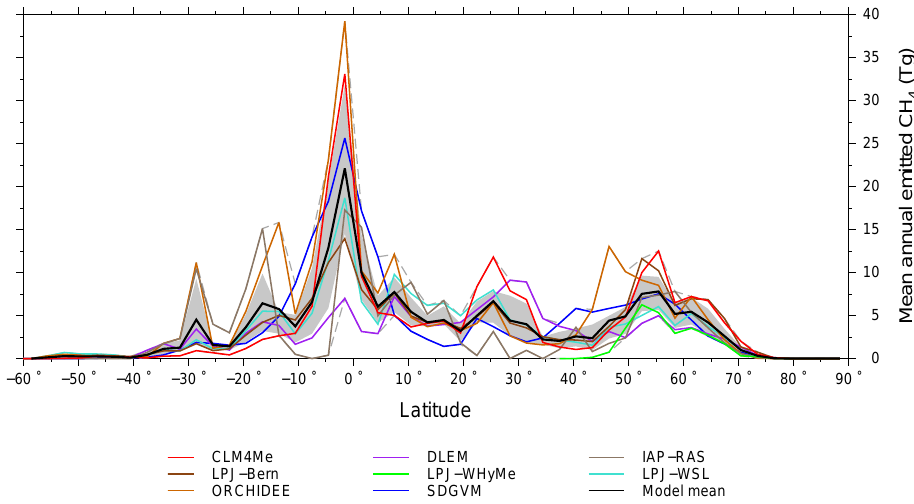
Fig. 5. Zonally summed mean annual CH 4 emissions for 1993–2004. The grey shading denotes the limits of the 25th and 75th percentile of the model distribution. Grey dashed lines are the 5th and 95th percentile limits. The CH 4 emissions are summed across 3 ◦ bins.